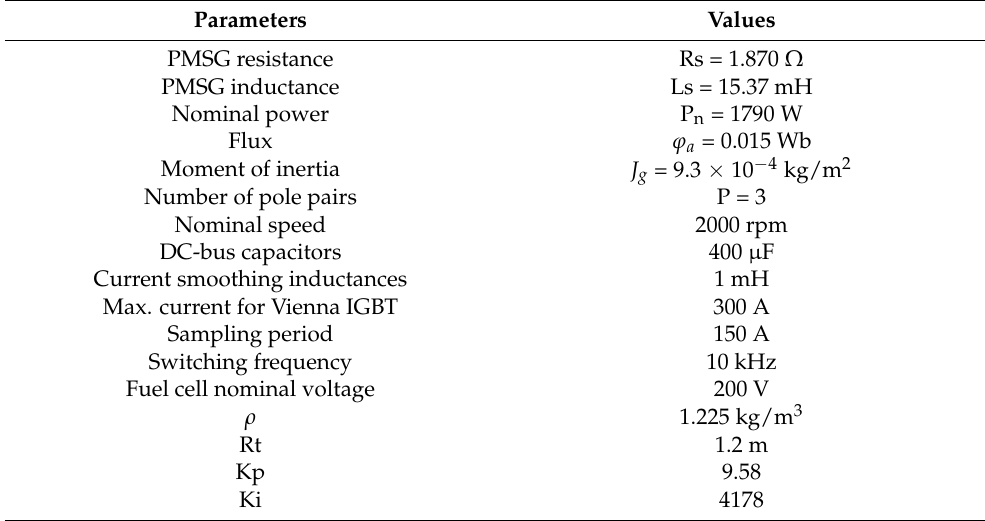
Table 2. Parameters of the PMSG and wind turbine control.